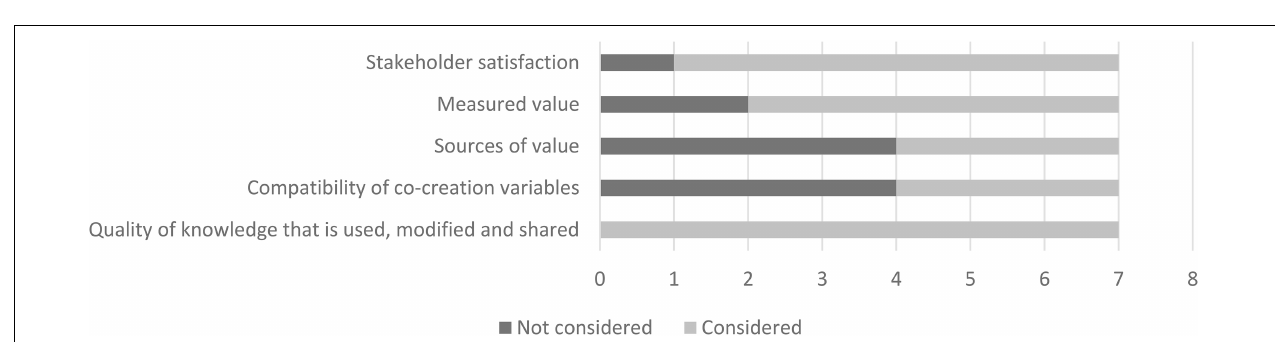
FIGURE 6 | Consideration of concepts used to strategically prioritize and conduct activities.